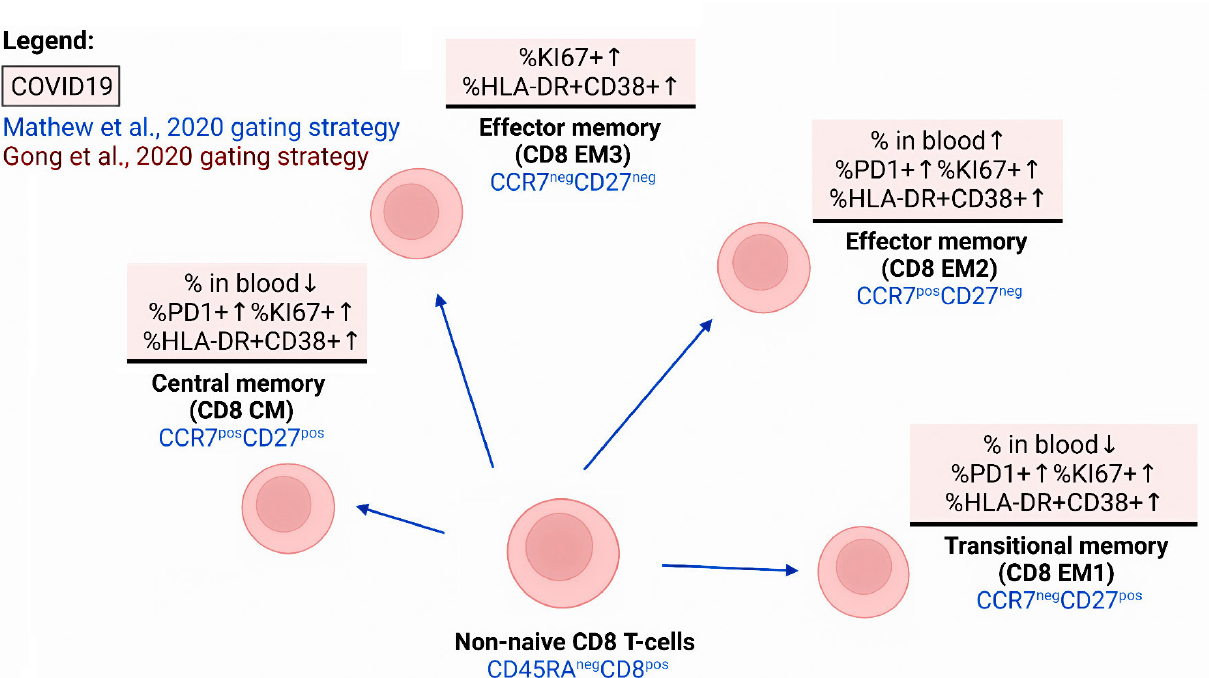
Figure 5. Impairment of peripheral blood CD8+ T cell subsets maturation in patients with COVID-19. Abnormalities of cytotoxic T cell maturation were linked with the increase in effector Th cell subsets. The relative number of activated (CD38+ and HLA-DR+) and ‘enhanced’ (PD-1+ and TIM-3+) cells were increased during the acute phase of SARS-CoV-2 infection.